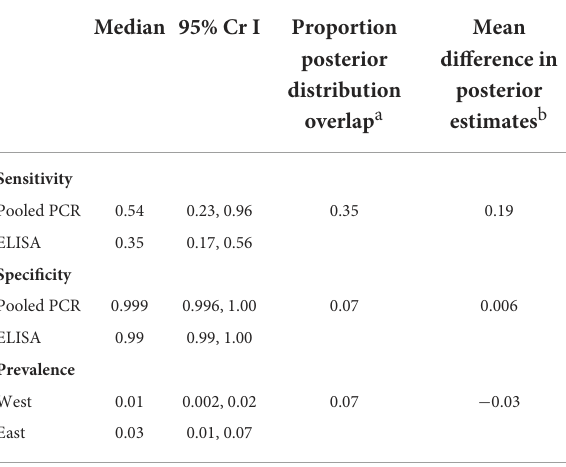
TABLE 5 Sensitivity and specificity estimates for MAP diagnosis in 3,171 beef cows in the absence of a gold standard using a two-test, two population Bayesian latent class model with non-informative